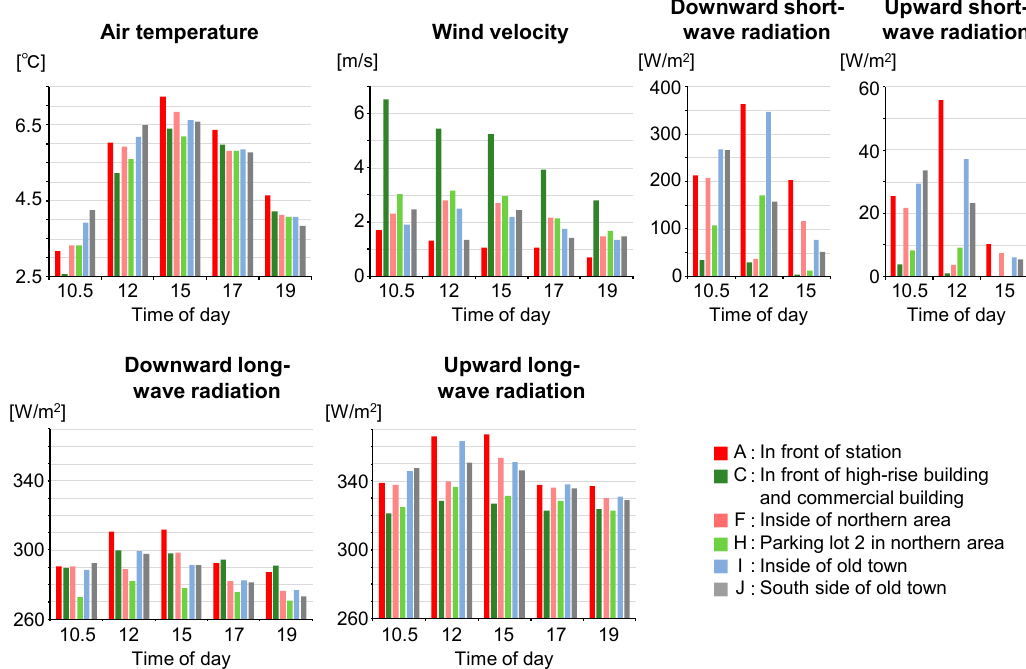
Figure 11. Daily variations of mobile observation results averaged over each section.